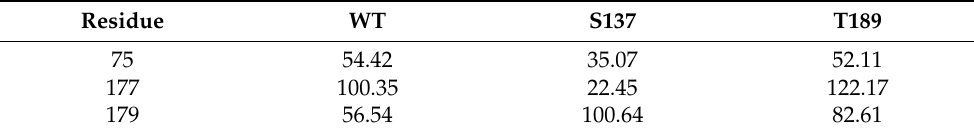
Table 7. Solvent accessible surface area (SASA) score for residues 75, 177, and